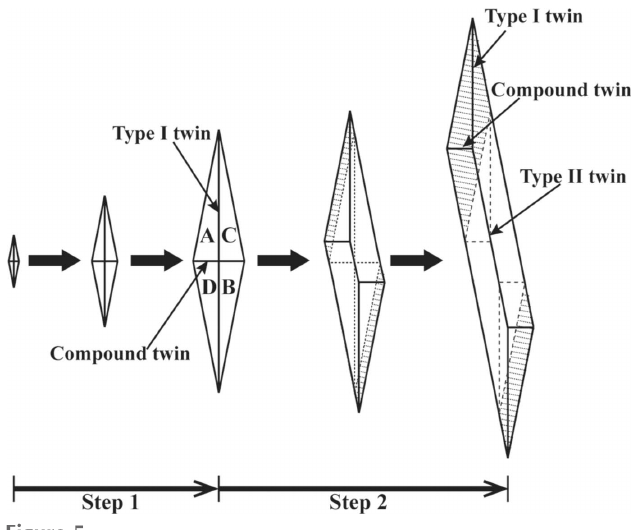
Figure 5 A schematic illustration of the two-step growth of 7M martensite from a diamond shape to a spearheaded